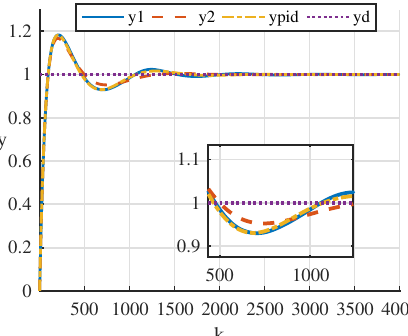
Figure 9. The output obtained by each control algorithm and the desired output.